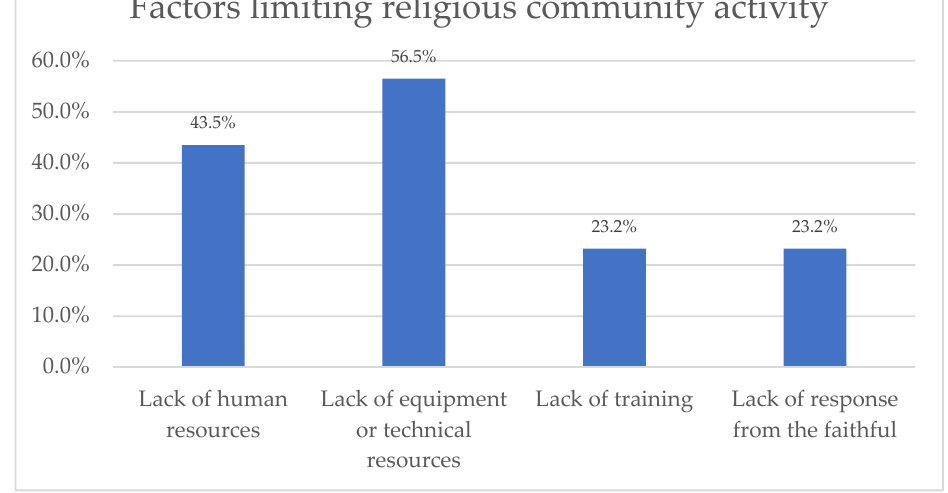
Figure 5. Limitations found by the community for digitalization. Source: Authors.